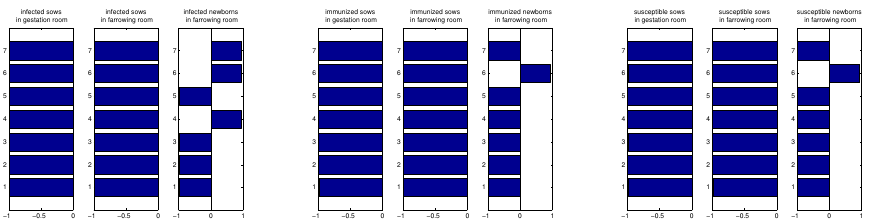
Fig. 19 Correlations between the system’s parameters and the infected (left), immunized (center) and susceptible (right) populations in the gestation and farrowing units. The parameters, bottom to top, are the following ones: m , α , τ , ∆ , β , b , γ . In each frame, the left column contains the results relative to the sows in the gestation room, the central one the sows in the farrowing unit and the right one the newborns in the farrowing